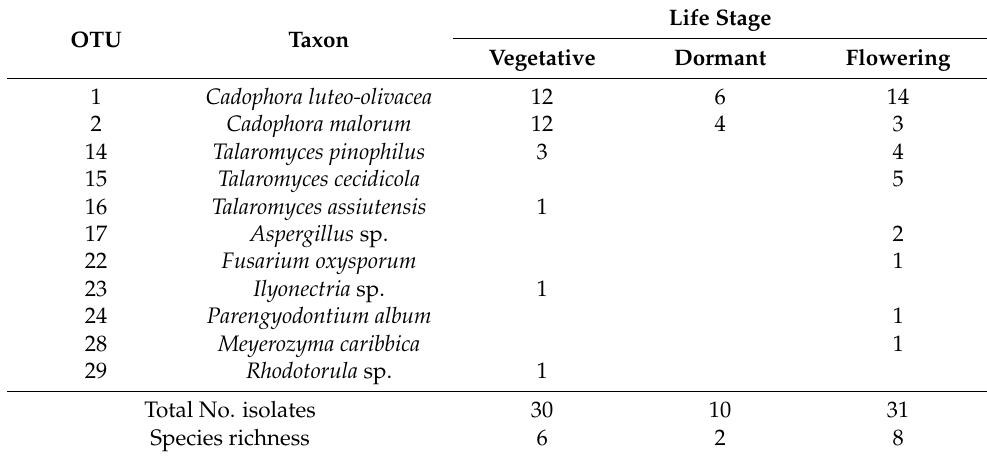
Table 4. Diversity of fungal endophytes in corms of C. sativus at the vegetative, dormant, and flow ‐ ering stages.